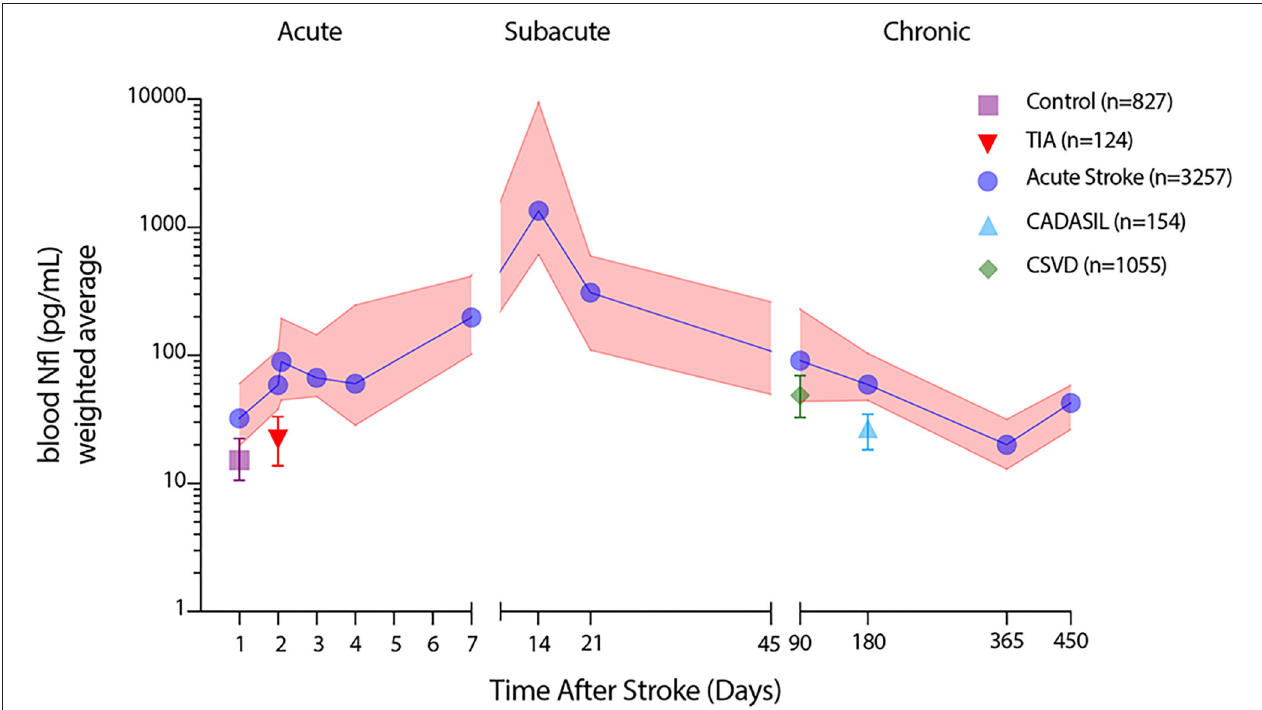
FIGURE 3 | Temporal patterning of blood NfL values measured by SIMOA during distinct acute ischemic stroke epochs. Weighted averages of median blood NfL values (blue) at defined time points after stroke with weighted average interquartile range (pink shading) along with weighted average median blood NfL values and interquartile ranges for healthy controls, transient ischemic attack (TIA), cerebral small vessel disease (CSVD), and cerebral autosomal dominant arteriopathy with subacute infarcts and leukoencephalopathy (CADASIL) subjects.